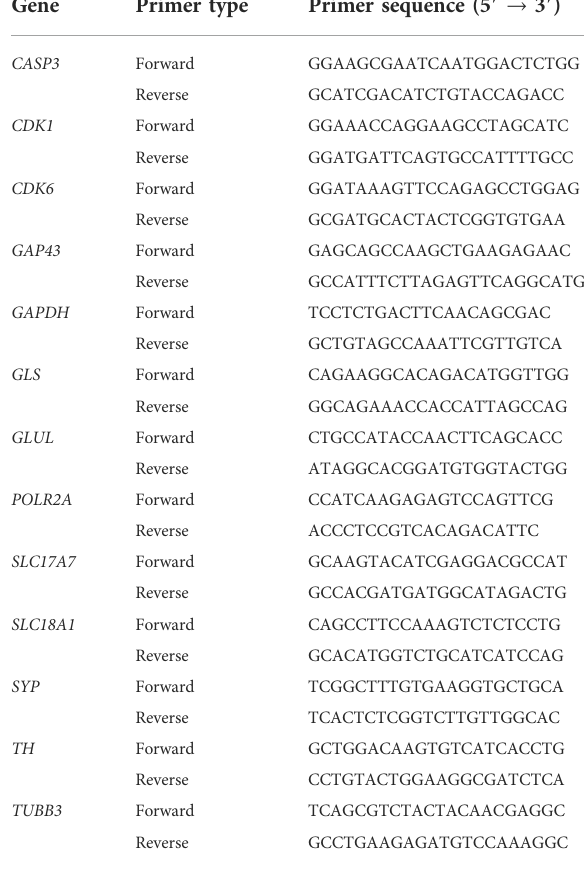
TABLE 1 qRT-PCR primers used in this study. All primers were reconstituted with PCR-grade ddH2O to 100 μ M, before being used in qRT-PCR experiments at a concentration of 10 μ